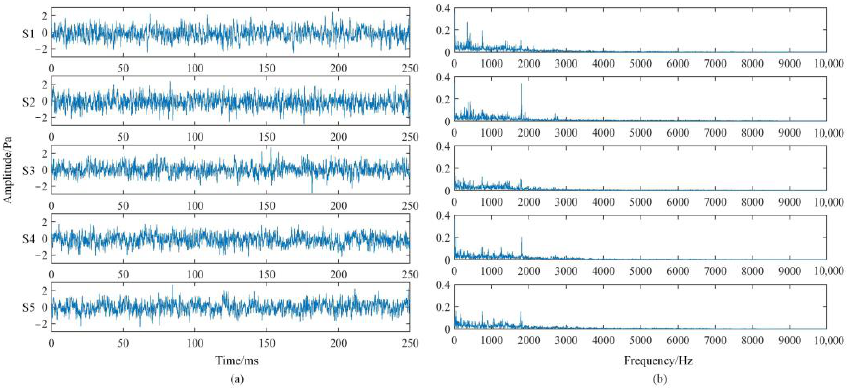
Figure 7. Sound pressure signal in different states: ( a ) time domain diagram; ( b ) frequency domain diagram.